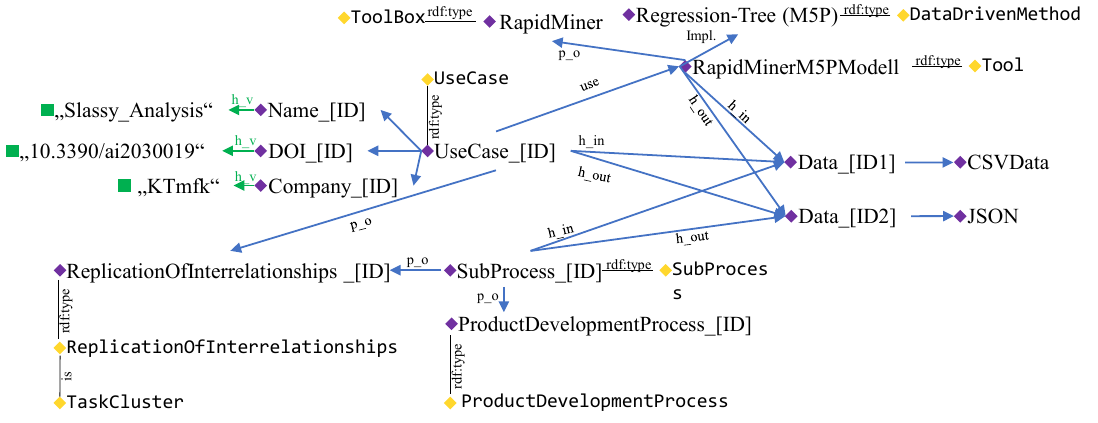
Figure 7. Formal setup of the SLASSY use case. (core concepts: yellow diamonds, relationships: blue arrows, individual instances of a concept: purple diamonds, properties: green